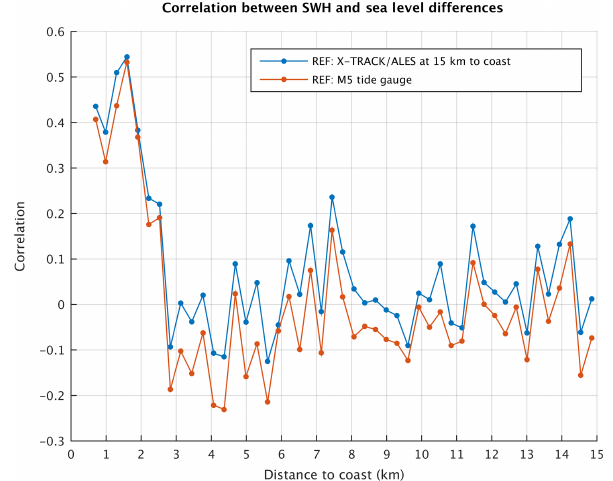
Figure 15. Correlation between the wave height (SWH) time series (from ERA5 grid mesh close to Senetosa) and altimetry-based sea level difference time series between every 20Hz point and a refer- ence point. The blue curve corresponds to a reference time series for a point located 15km from the coast. In the case of the red curve, the reference time series is the M5 tide gauge